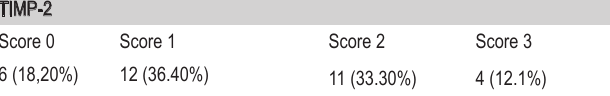
Table 2 - Expression score of TIMP-2 in OSCC.